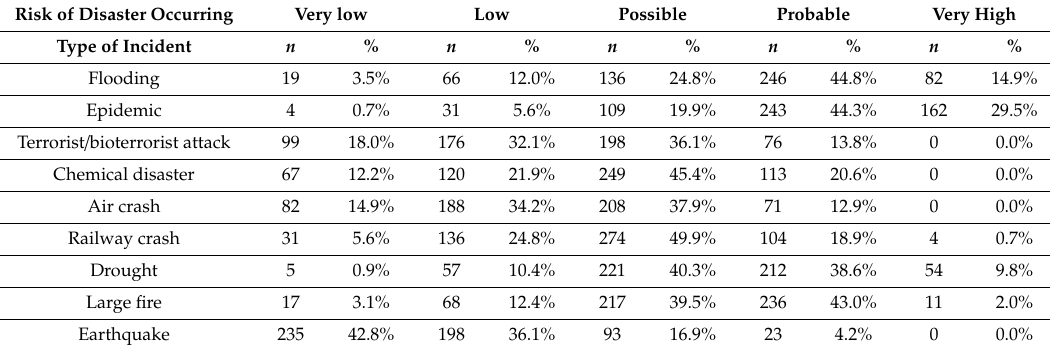
Table 2. Likelihood of disasters occurring in Lublin in the next five